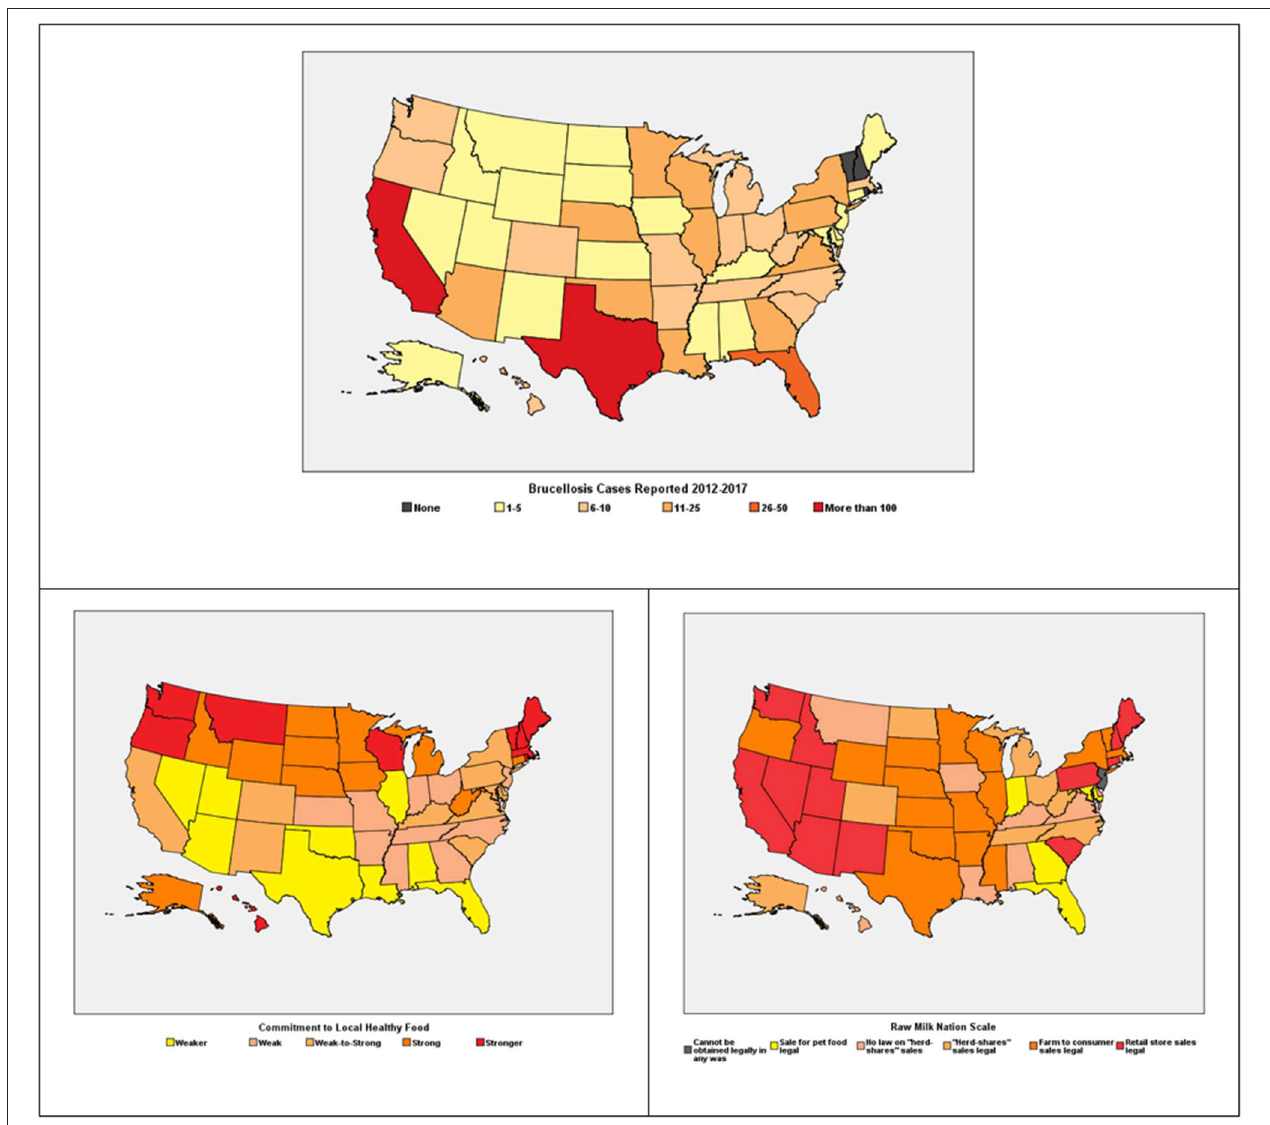
FIGURE 6 | Number of confirmed cases of brucellosis in the US reported to the CDC. Outbreak of raw milk related diseases including brucellosis have been reported mostly in states that permit the sale of raw milk. Lovacore Index—A measure of the commitment of individuals to local healthy food. Legal status of the sale of raw milk in the United